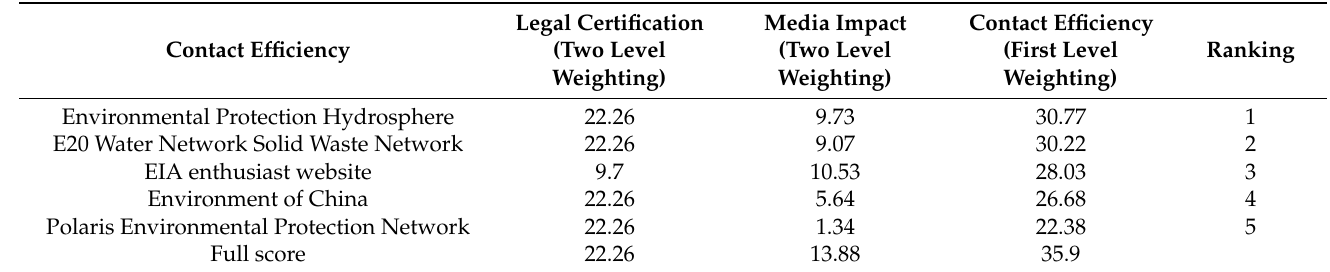
Table 9. Score and Ranking of Contact Effectiveness.